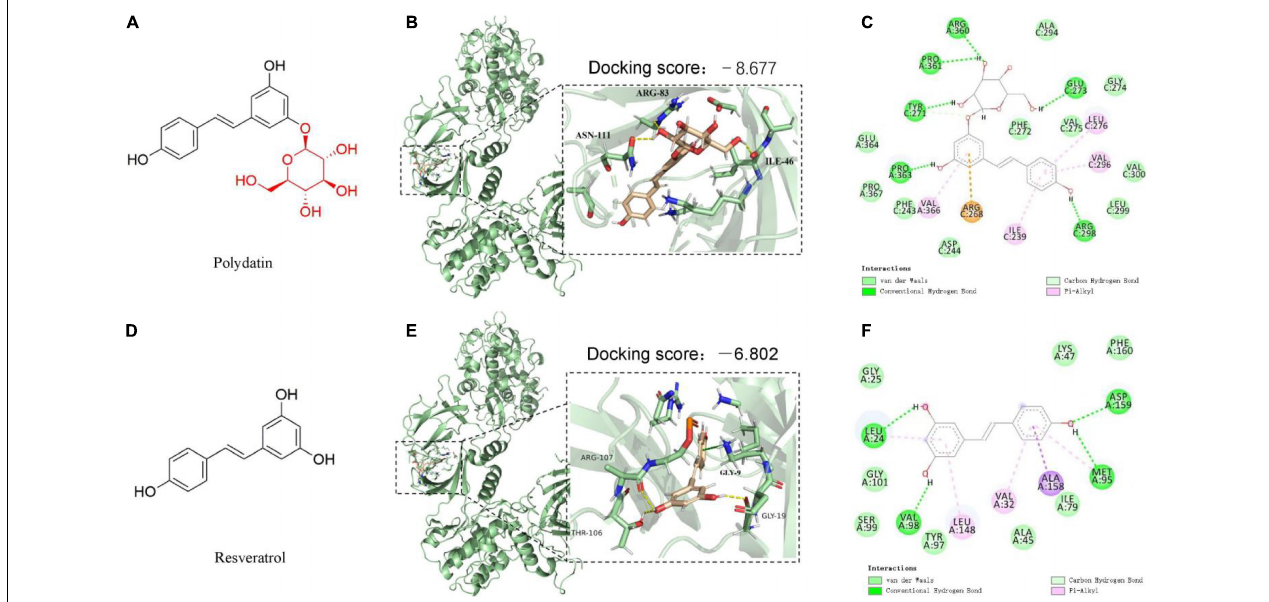
FIGURE 1 | The predicted binding modes of polydatin (POD) and resveratrol (RES) docked into AMP-activated protein kinase (APMK). (A,D) Chemical structures of POD and RES, respectively. The binding location of AMPK (black box area) interacting with POD and RES were shown as molecular surface structures in 3D docking model (B,E) ; H-bonds and hydrophobic interactions between POD or RES and AMPK in a 2D docking model (C,F)